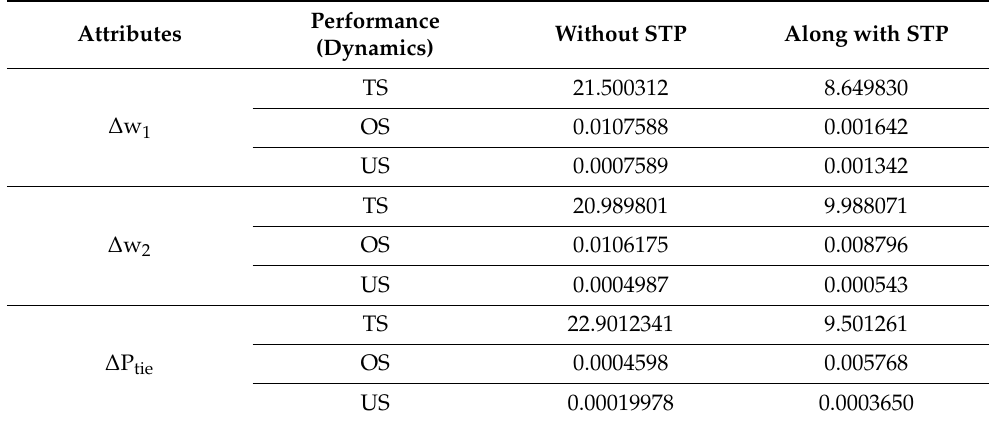
Table 6. Performance attributes dynamics without and with STP (Undershoot—US, Overshoot—OS, and Time to